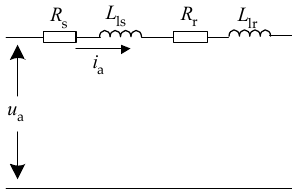
Figure 4. Single-phase AC equivalent circuit in high frequency, where the magnetizing inductance of the motor is neglected.